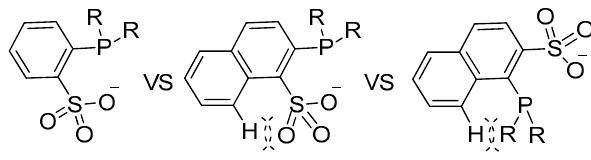
Scheme 3. Comparison of the three ligand frameworks.